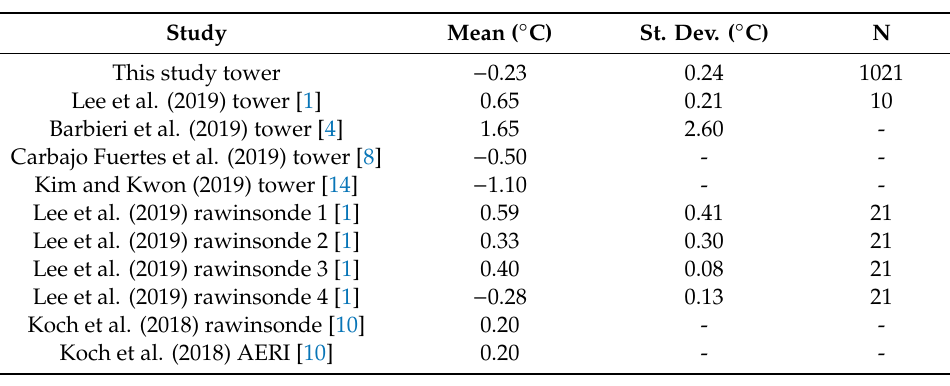
Table 2. Mean and standard deviations of temperature di ff erences ( ◦ C) between the UAV-based sensors and the tower or rawinsonde temperature measurements (T UAV –T Tower ) for the current study